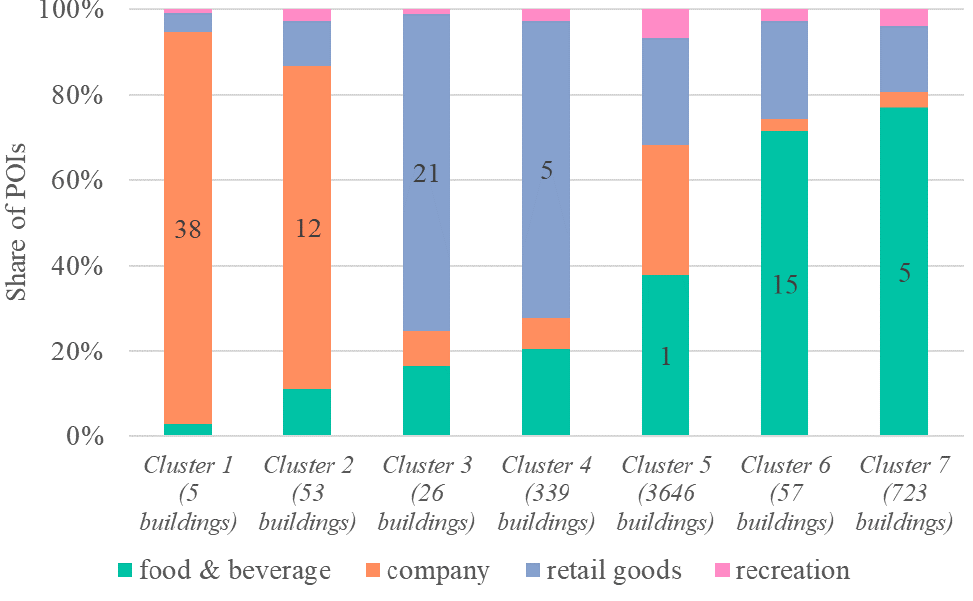
Figure 7. Buildings with no main attribute clustering.